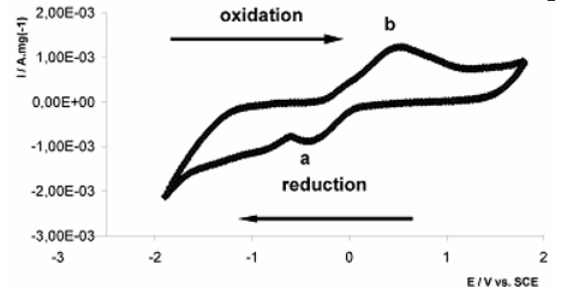
Figure 1. Cyclic voltammogram ( υ = 100 mV s -1 ) of Bi-modified- electro-oxidized carbon fibres in 0.01 M KHC H O - HCl, 8 4 4 pH=4. (a) Bi +3 → Bi 0 , (b) Bi 0 → Bi +3 . Electrode modification: by dipping the electrochemically activated carbon fi bres in 200 mg L -1 Bi(NO ) •5H O - 1% HNO for 24 h. Electrode 3 3 2 3 weight: 2.0 mg / 2.5 cm (depth). Oxidation current (start): 19 μ Α , oxidation current (switching):14 μ Α